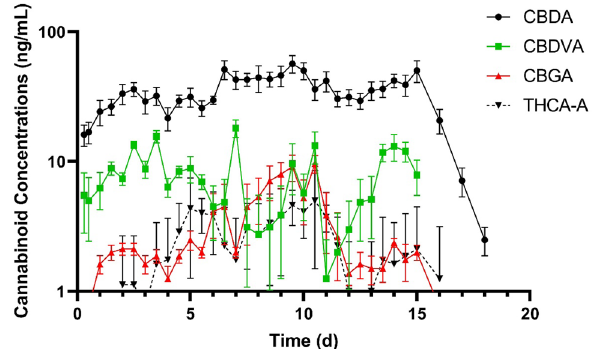
Figure 1. Mean plasma concentrations (ng/mL) of cannabidiolic acid (CBDA) at 5.5 mg/kg, cannabidivarinic acid (CBDVA) at 0.02 mg/kg, cannabigerolic acid (CBGA) at 0.2 mg/kg, and tetrahydrocannabinolic acid-A